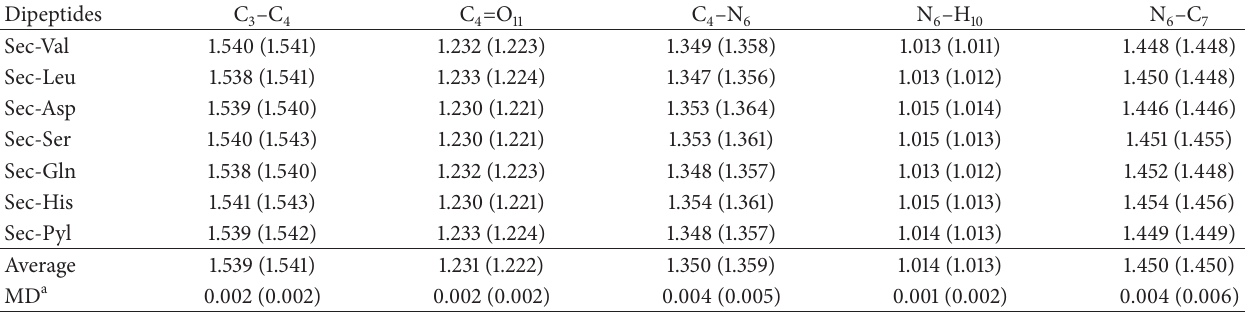
Table 2: Calculated bond lengths (in angstrom) for the peptide planes of the dipeptides; the gas phase values are given in brackets.